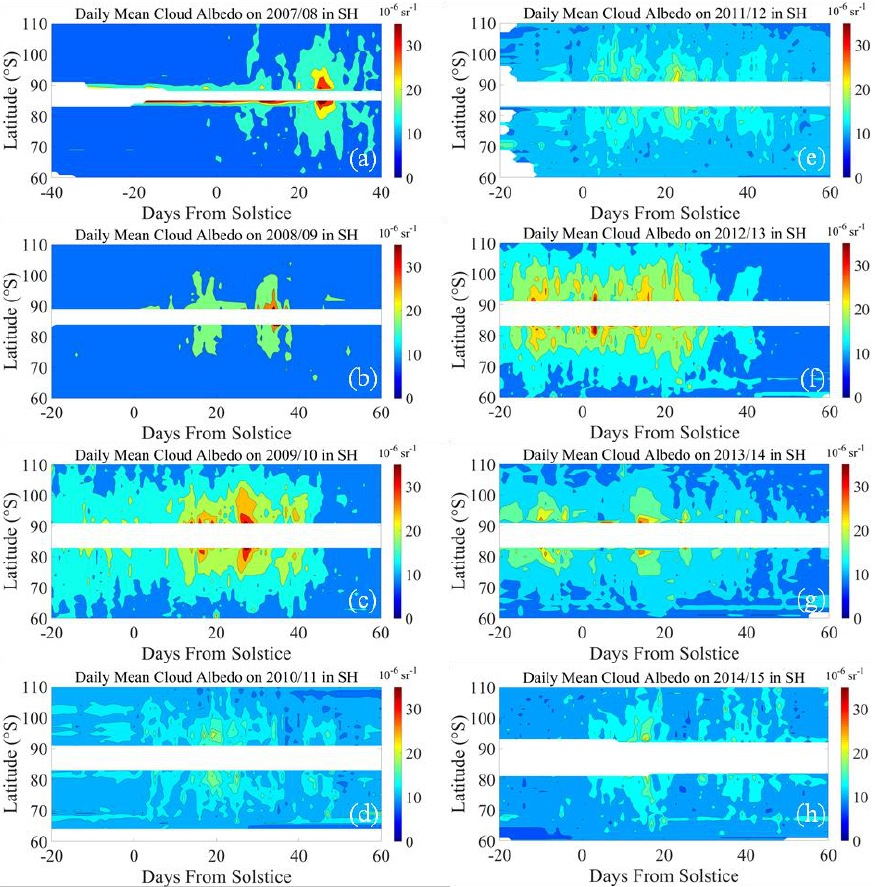
Figure 8. The cloud albedo distributions of the PMC seasons from 2007/2008 to 2014/2015 in the SH. ( a ) Cloud albedo on 2007/2008 PMC season; ( b ) Cloud albedo on 2008/2009 PMC season; ( c ) Cloud albedo on 2009/2010 PMC season; ( d ) Cloud albedo on 2010/2011 PMC season; ( e ) Cloud albedo on 2011/2012 PMC season; ( f ) Cloud albedo on 2012/2013 PMC season; ( g ) Cloud albedo on 2013/2014 PMC season; ( h ) Cloud albedo on 2014/2015 PMC